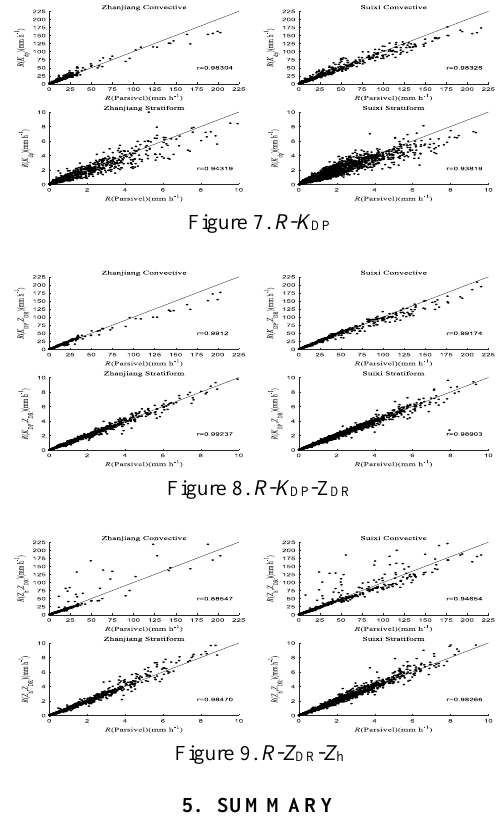
Figure 9. R - Z DR - Z